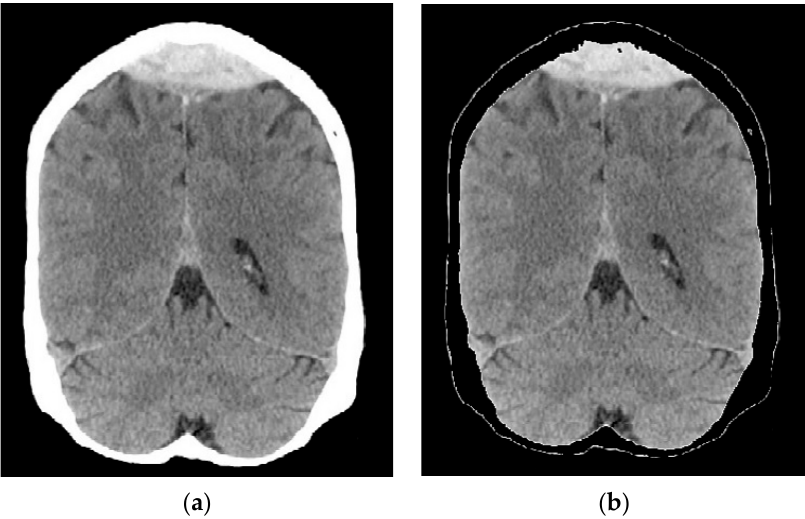
Figure 2. Illustration of computed tomography (CT) images ( a ) before and ( b ) after removing the skull.